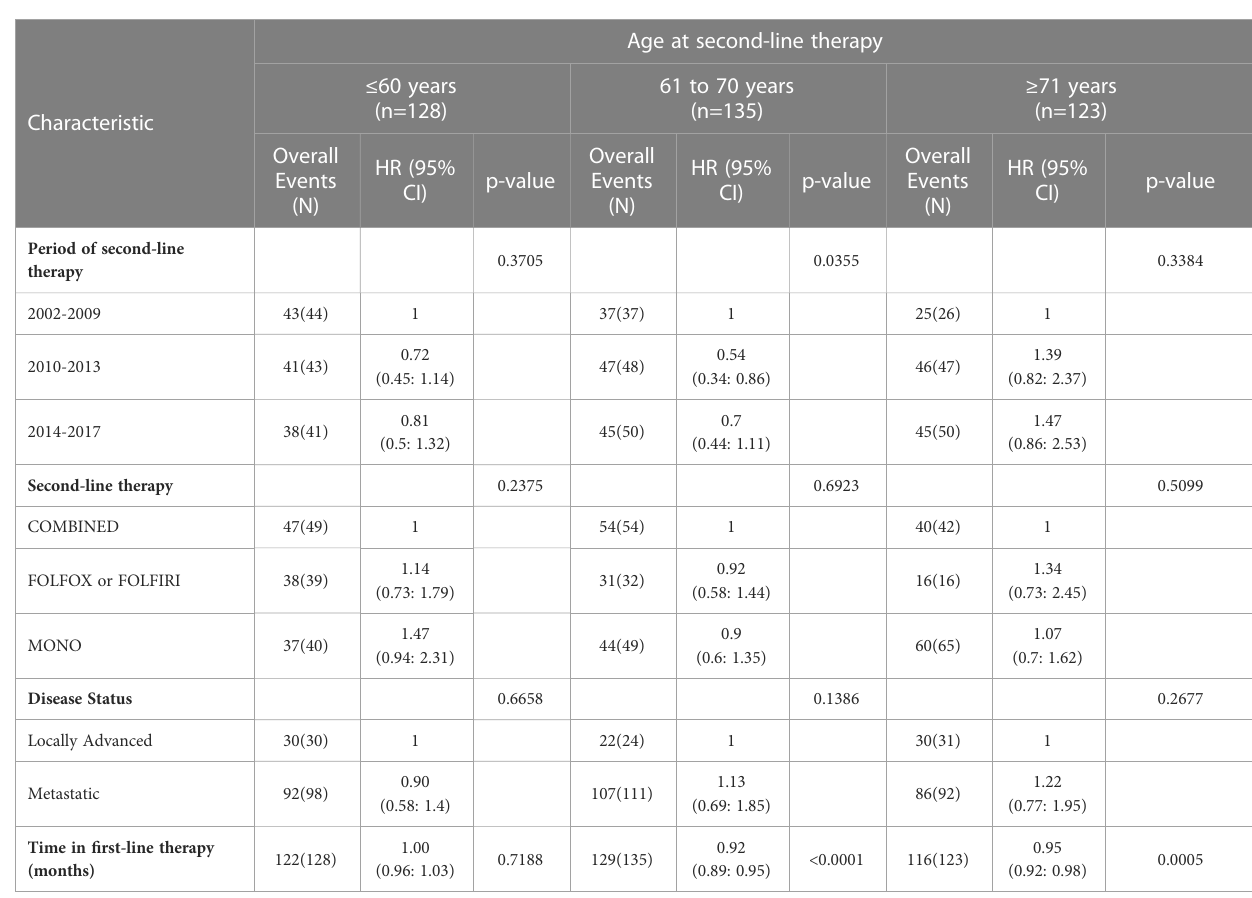
TABLE 6 Subgroup analysis of the period of second-line therapy on PFS by age.